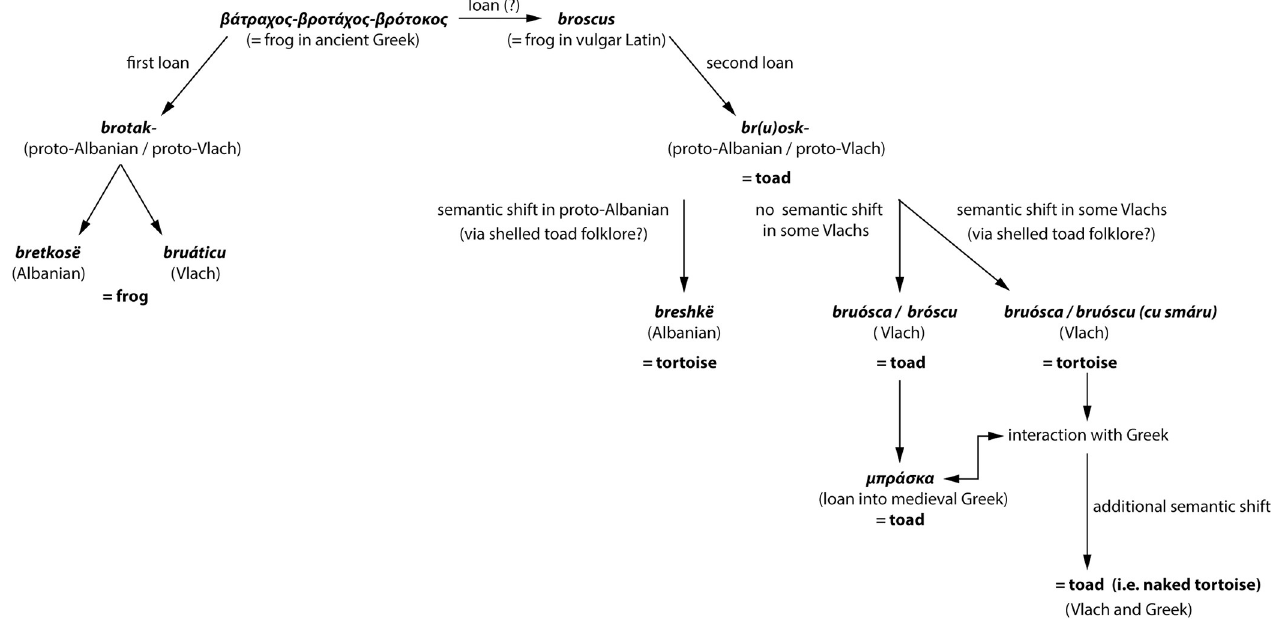
Fig 13. Hypothetical reconstruction of the linguistic and semantic evolution of the ancient Greek zoonym β ροτά χ ο B and vulgar Latin broscus in proto- Albanian and proto-Vlach.